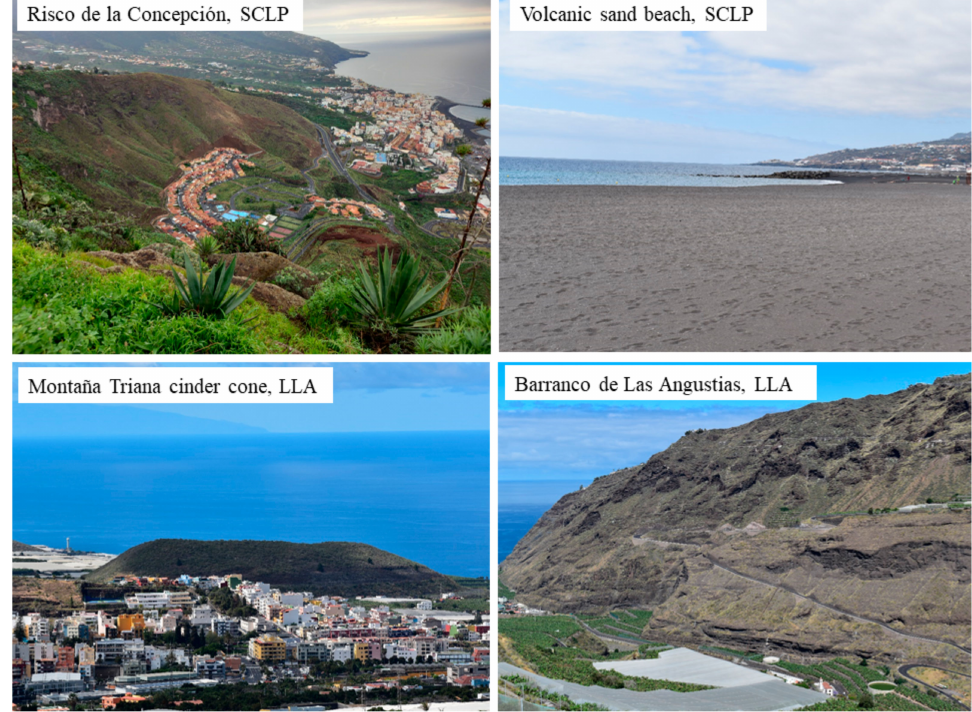
Figure 7. Natural heritage in SCLP and LLA cities. Source: